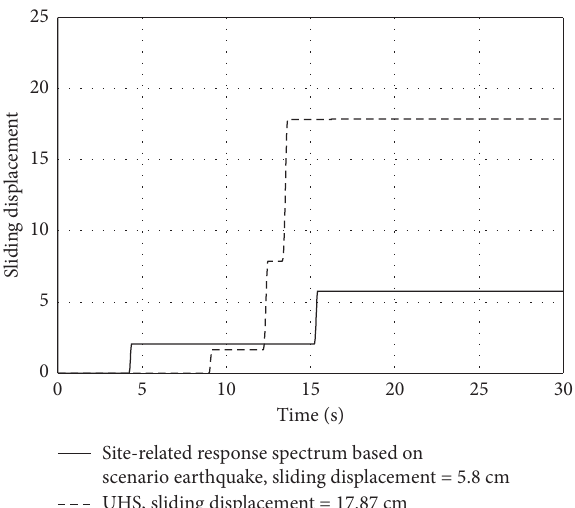
Figure 10: Sliding displacement with time in the downstream dam